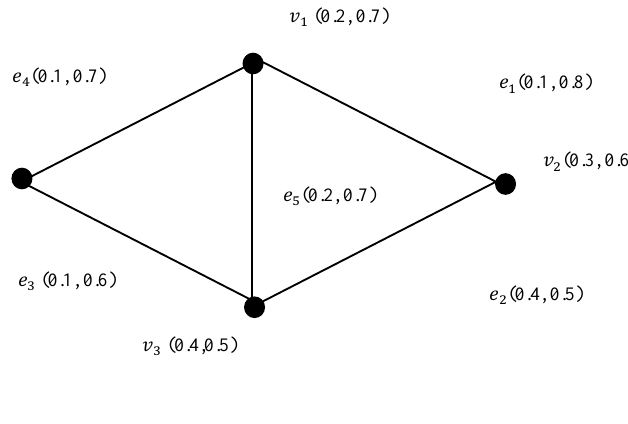
Figure 3.3: Perfect edge domination